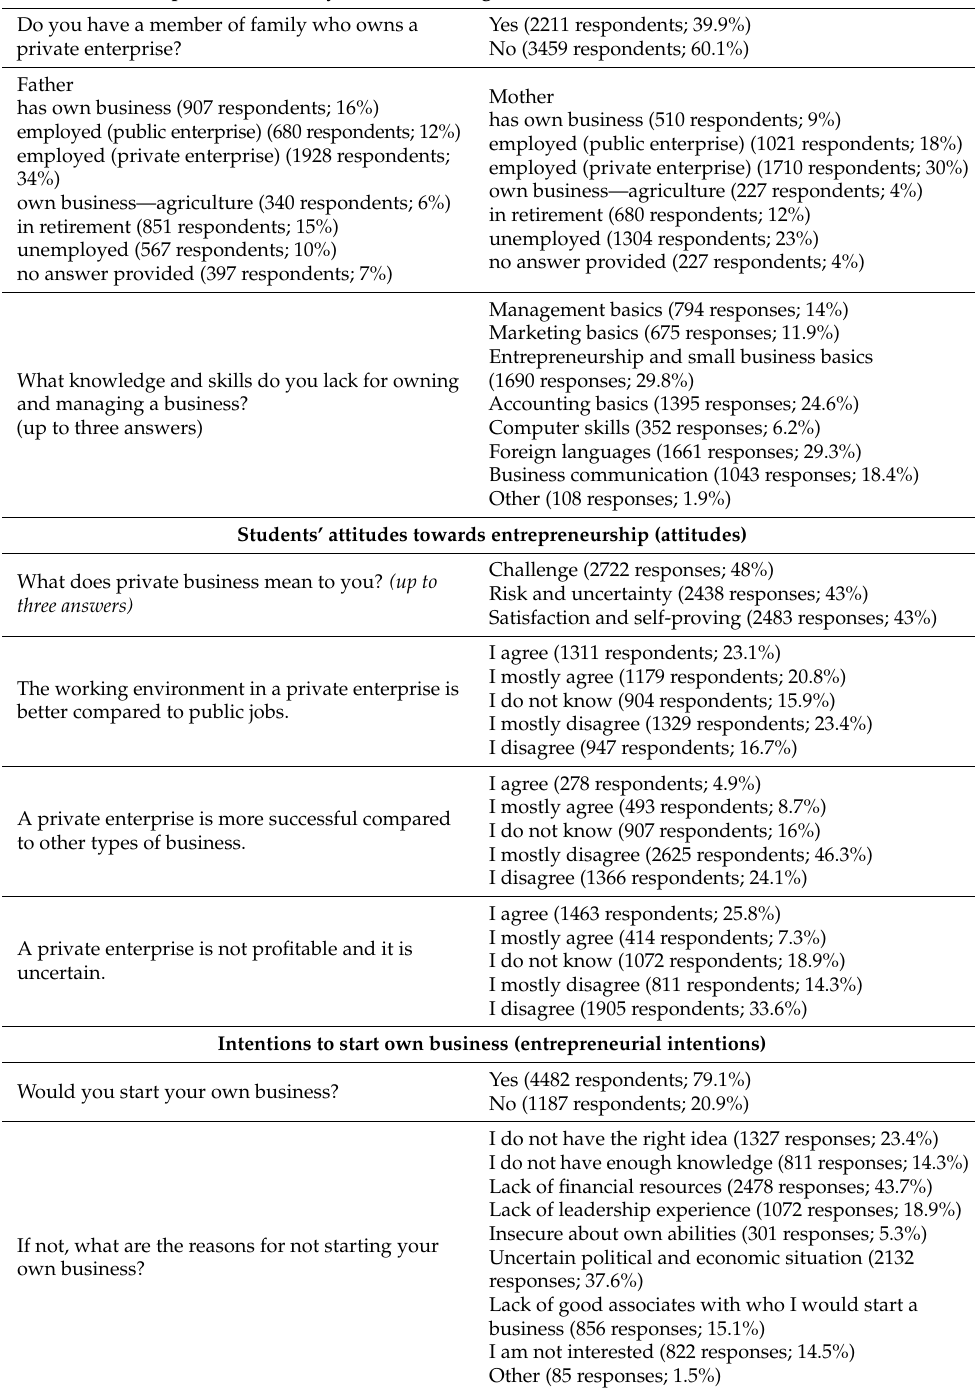
Table A2. Cont. Experience of family member owning a business (close social